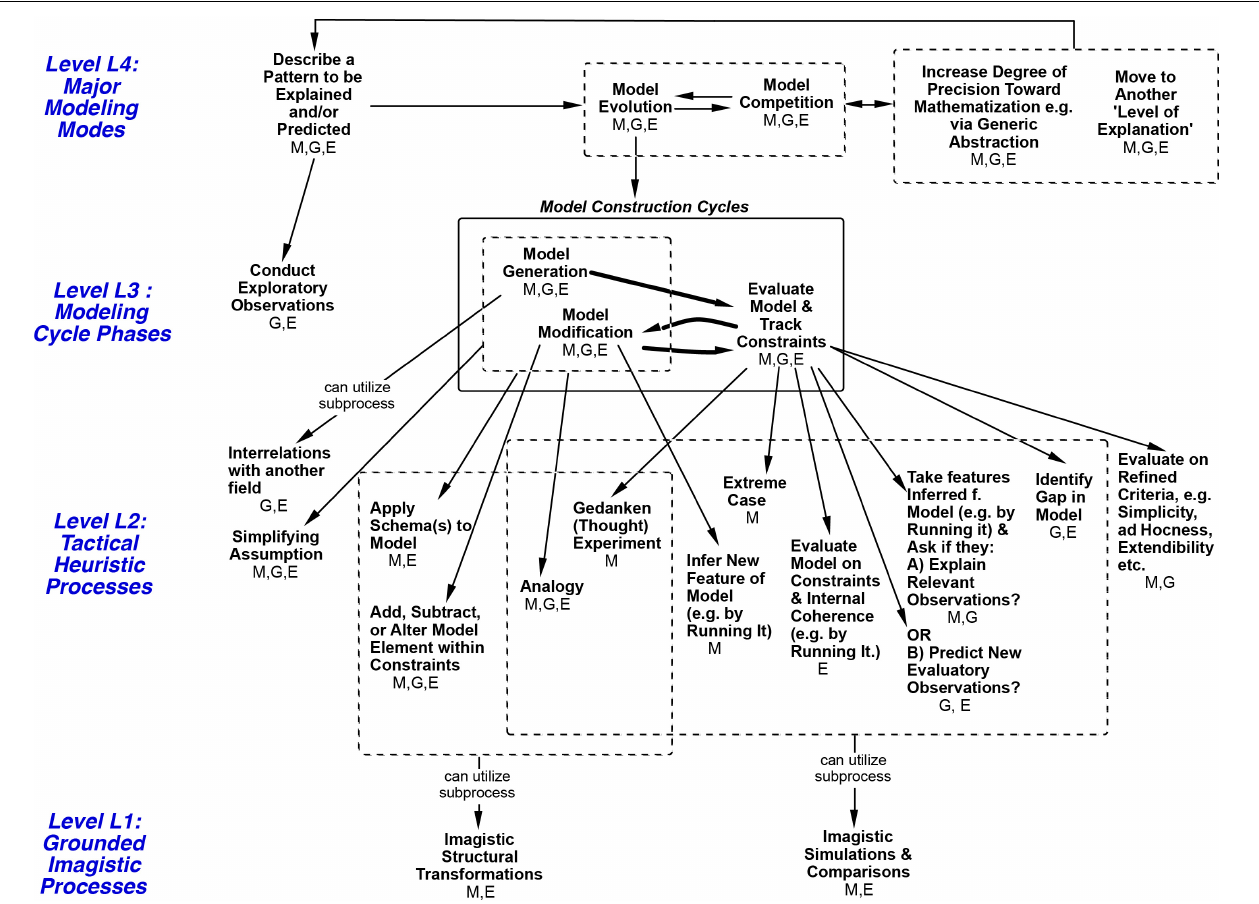
FIGURE 6 | Modeling Processes Framework with four levels of reasoning processes. The framework represents a process hierarchy. Higher levels are hypothesized to contain larger tasks at longer time scales. Horizontal arrows show possible sequences. Arrows between levels mean ‘Can utilize subprocess’. A subprocess can contribute to a larger goal/process above it. For example, S2’s episode 2 in Table 2 is an episode of Model Evolution at Level 4, implemented in part by Evaluate Model at Level 3, which is in turn implemented by the subprocess Ask if Model Explains Relevant Observations at Level 2, implemented via a Mental Simulation comparison at Level 1. The GEM cycle at Level 3 can be envisioned as accessing and alternating between processes on the left and right sides below it at Level 2. At Level 2, within each set (such as those under ‘Evaluate Model’). the processes are not shown in any necessary order. All processes in the figure are heuristic in being not guaranteed to work, although ‘Tactical Heuristic Processes’ is used to name Level 2 because items at that level are historically most associated with the term ‘heuristics’. Initials under each process indicate fields where it was seen in this paper: M, Mechanics (S2); E, Electromagnetism (Maxwell); G, Genetics . The great majority of processes occurred in more than one field; this provides an initial indication that those are field-general processes (others may turn out to be as well). Note that at: Level L4: Only Model Evolution processes at Level 4 are unpacked in this diagram. Level L3 : Evaluation, for example, can be implemented by any of the seven subprocesses it is pointing to, in any order, singly or with more than one being used. Level L2 : L2 subprocesses for Model Evaluation at L3 are a different subset from the others at L2, indicating more structural guidance in the framework. Each Level 2 process is shown as a subprocess for only one process at Level 3, except for Analogy, Simplifying Assumption and Applying a Schema, which were found to occur with either Generation or Modification here (indicated by arrow originating from the dotted box at Level 3). Level L1: Similarly, the downward arrow from a dotted box at Level 2 to Level 1 indicates that the Level 2 processes within that box can each utilize the Level 1 strategy as a subprocess (to avoid drawing a profusion of